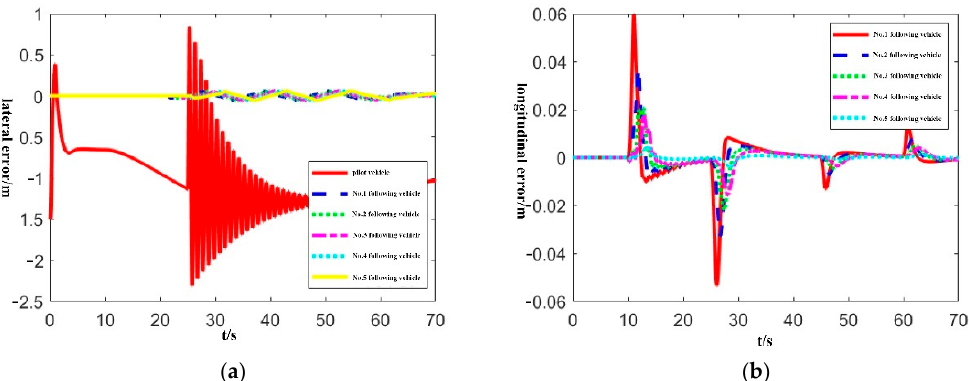
Figure 5. Lateral and longitudinal error curve in scenario 1. ( a ) Platoon lateral error; ( b ) Platoon longitudinal error.